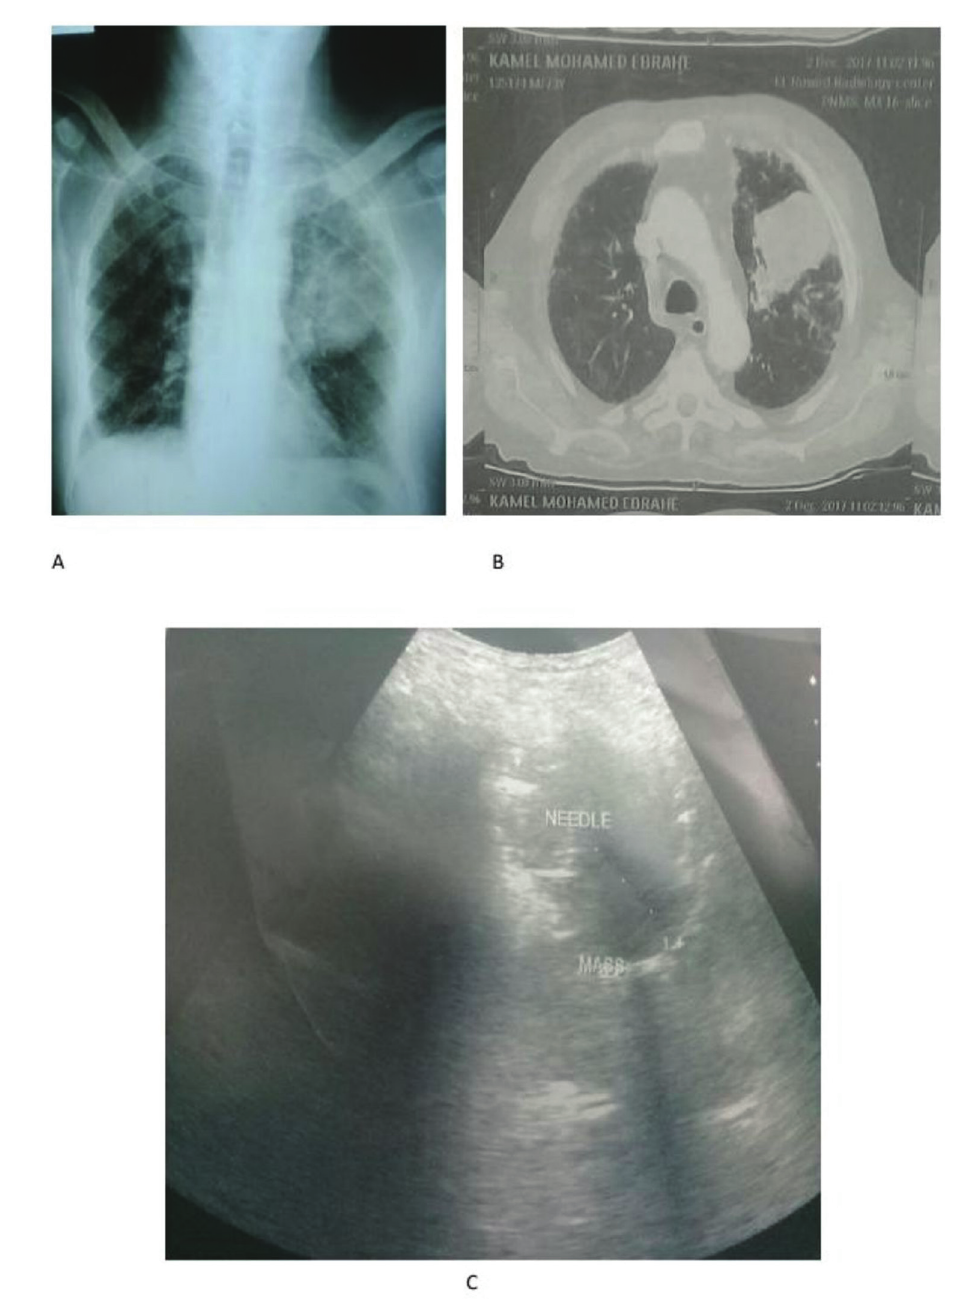
(a) Chest radiograph of a 63-year-old man showing upper left lobe opacity; (b) CT chest showing upper lobe mass of 5×4.5cm; (c) US image showing TNB entering the mass. CT, computed tomography; TNB, transthoracic needle biopsy; US, ultrasound.